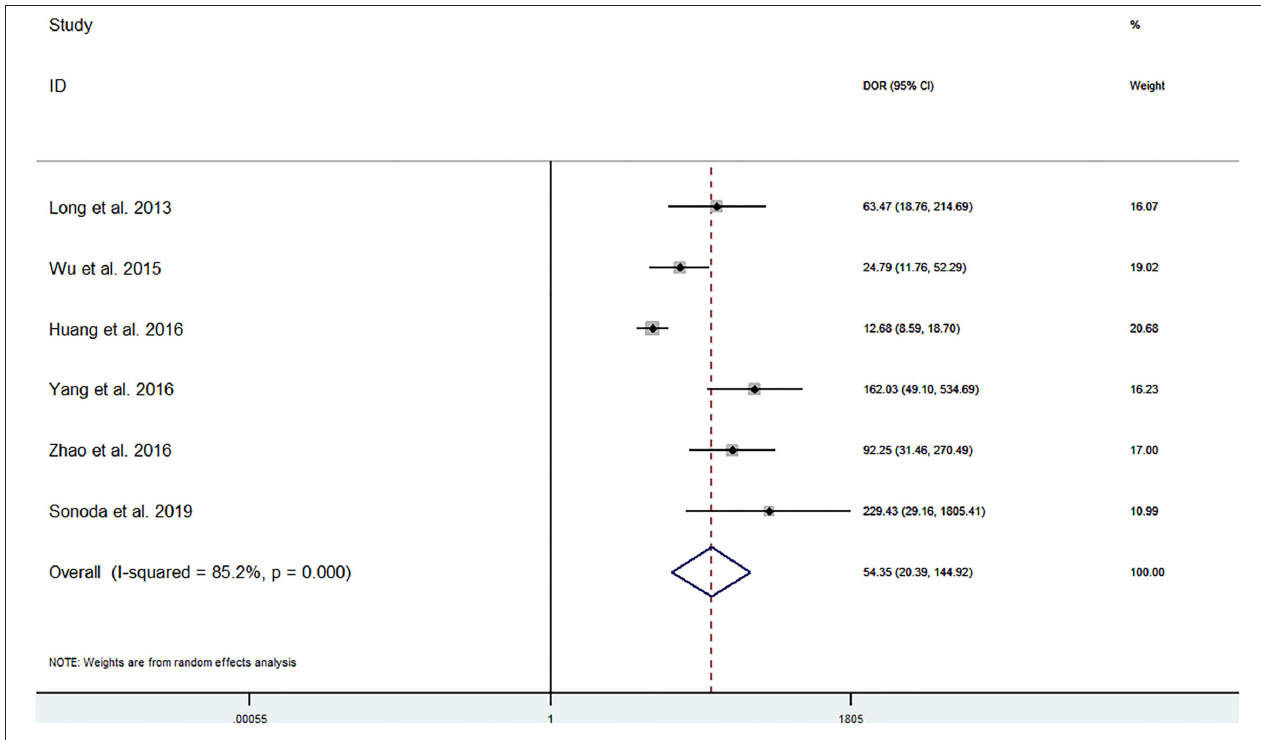
FIGURE 3 | Forrest plot of diagnostic odds ratio